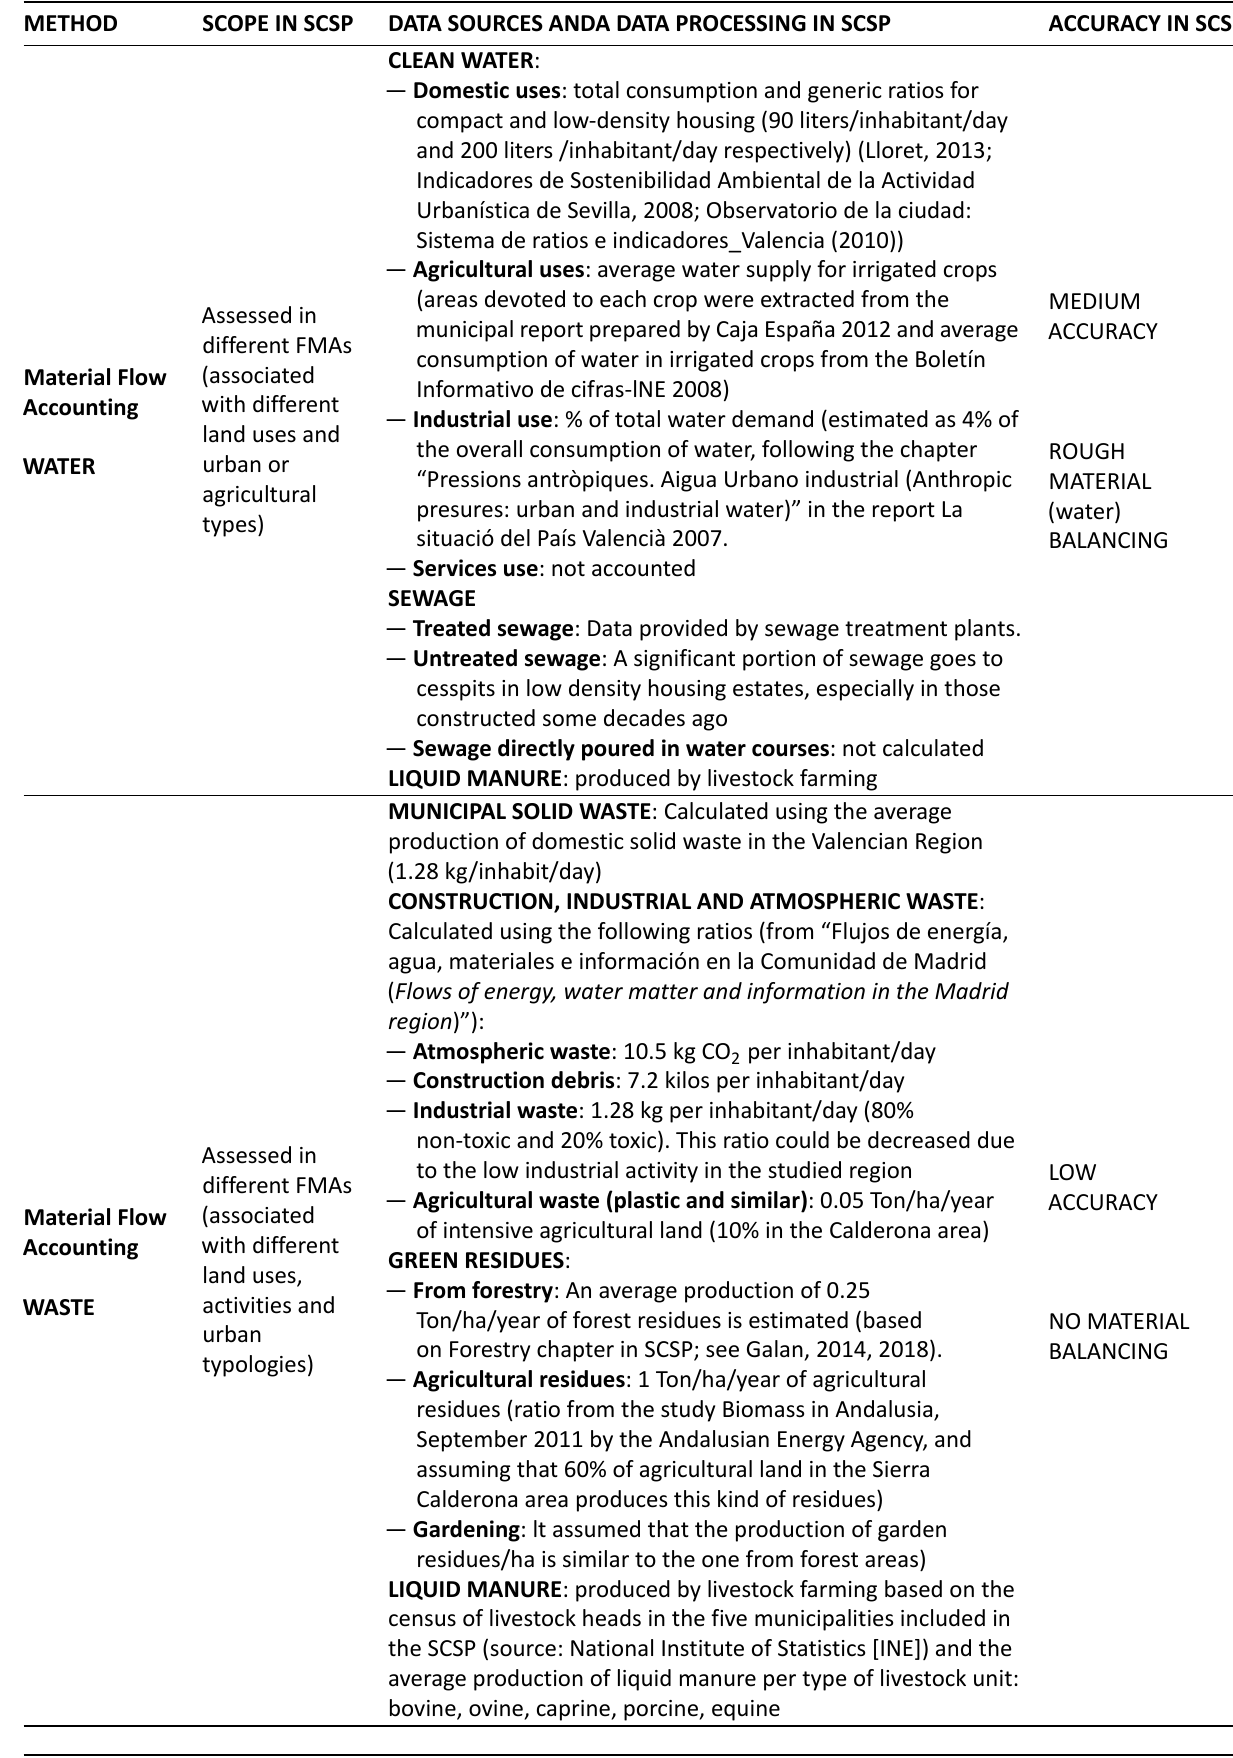
Table 1. Metabolic methods, application scopes, data sources and data processing used in the